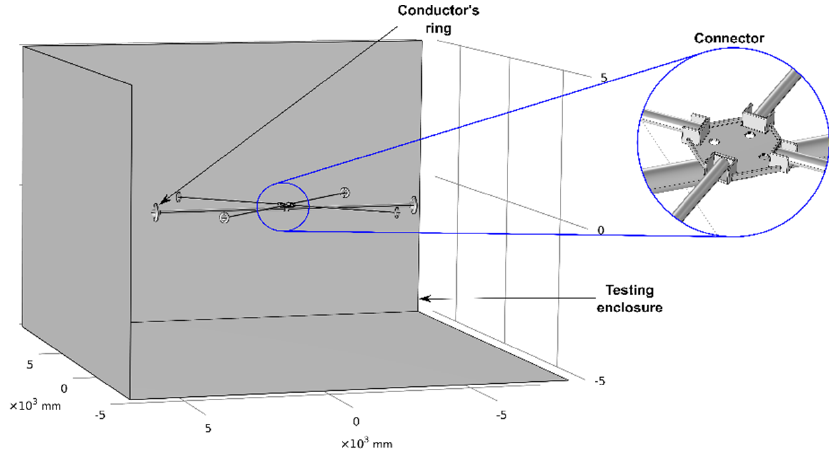
Figure 2. Modelled setup for the connectors. The box represents the testing room.